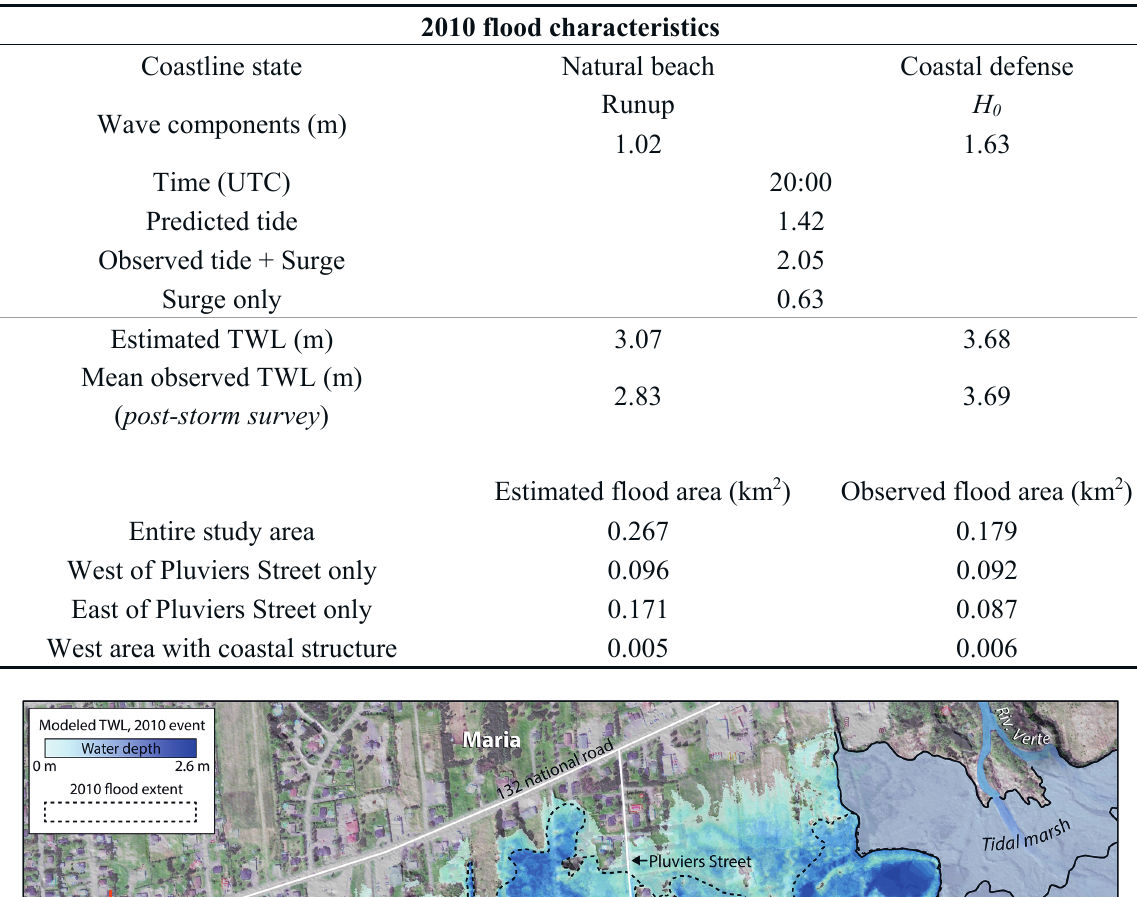
Table 2. Flood characteristics according to observed and predicted total water levels along natural and defended areas during the 2010 event.